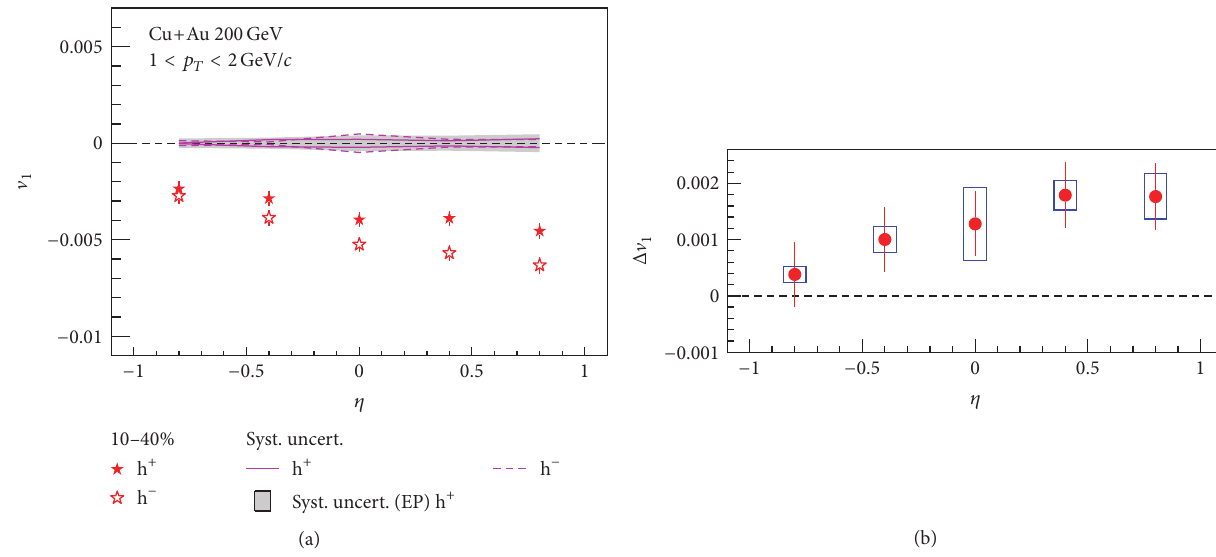
Figure 6: Directed flow as a function of pseudorapidity, separately evaluated for positively and negatively charged particles, at 1 < 𝑝 𝑇 < 2 GeV/ 𝑐 and centrality 10–40% in 200 GeV Cu+Au collisions in the STAR detector [70].